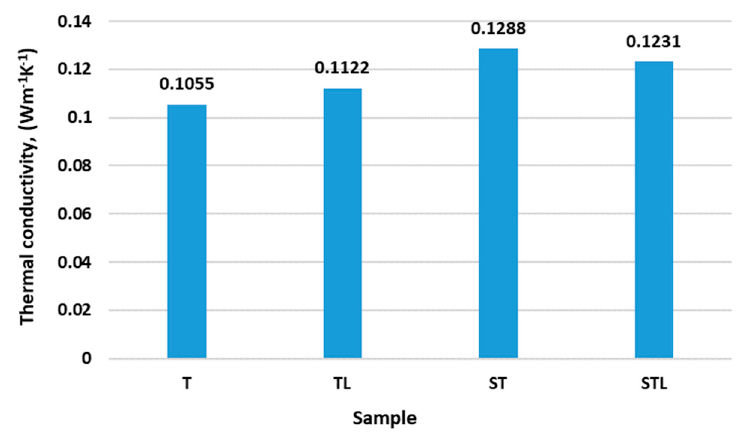
Figure 6. The results of thermal conductivity.